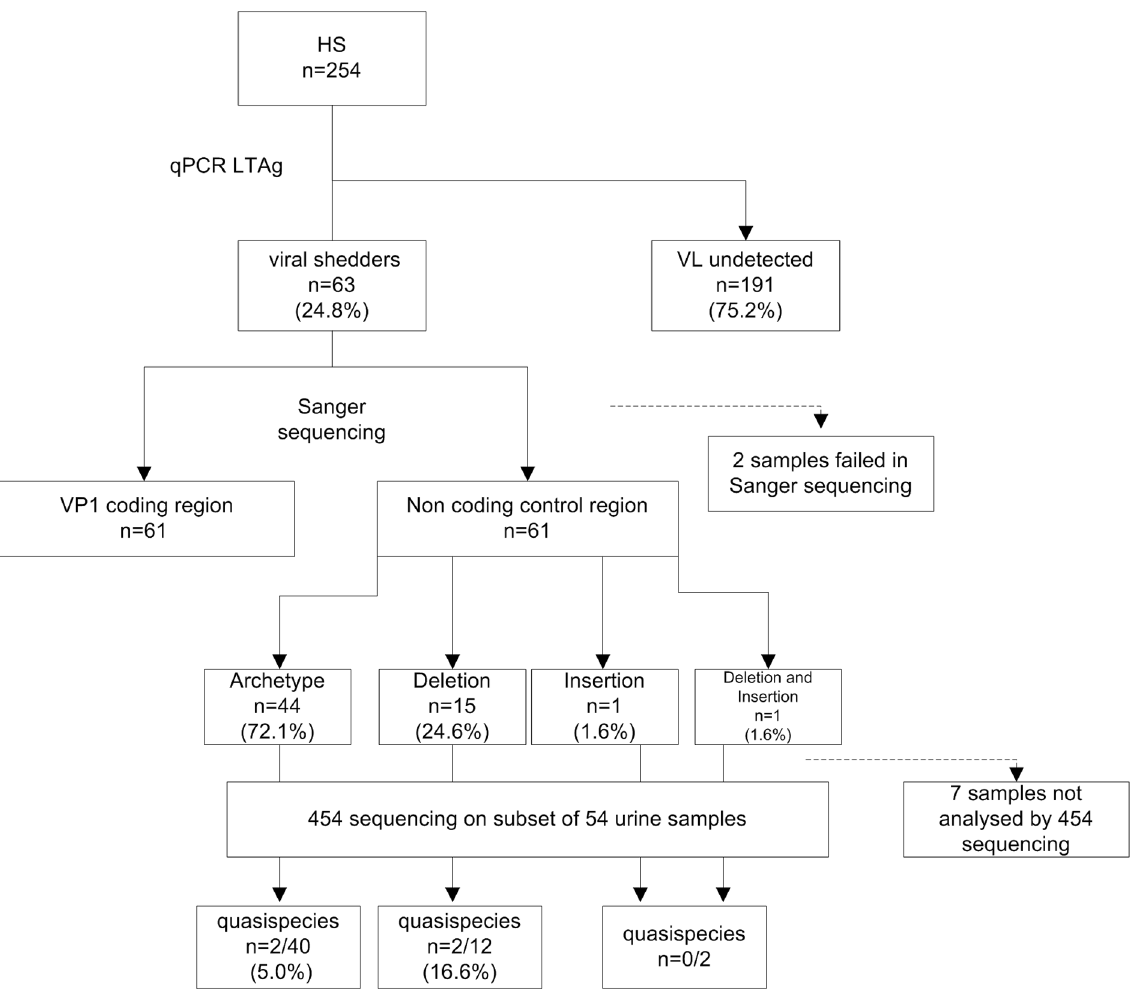
Figure 1. Outline of the experimental work presented. JC virus DNA was detected in urine of 63 out of 254 healthy subjects (HSs) by qPCR targeting the large T antigen (LTAg) gene. For 61 viral shedders the full length VP1 coding sequence and the non-coding control region (NCCR) DNA was obtained via Sanger sequencing. When compared to a reference archetype NCCR ( i.e. CY isolate, NCBI acc.nr. AB038249) 44 samples did not contain any rearrangement while 15 samples (24.6%) harbored a deletion (between 1 and 28 bp), 1 sample (1.6%) carried a duplication in the consensus NCCR sequence and 1 sample carried both an insert and a deletion. A subset of 54 urine JCV DNA samples were further analyzed by next generation sequencing (454 pyrosequencing) to specifically look at the presence of JCV quasispecies that were identified in 2 out of 40 archetype samples (5.0%) and 2 out of 12 samples (16.6%) that contained a deletion when analyzed by Sanger sequencing. No quasispecies were detected in both samples carrying a duplication in the consensus